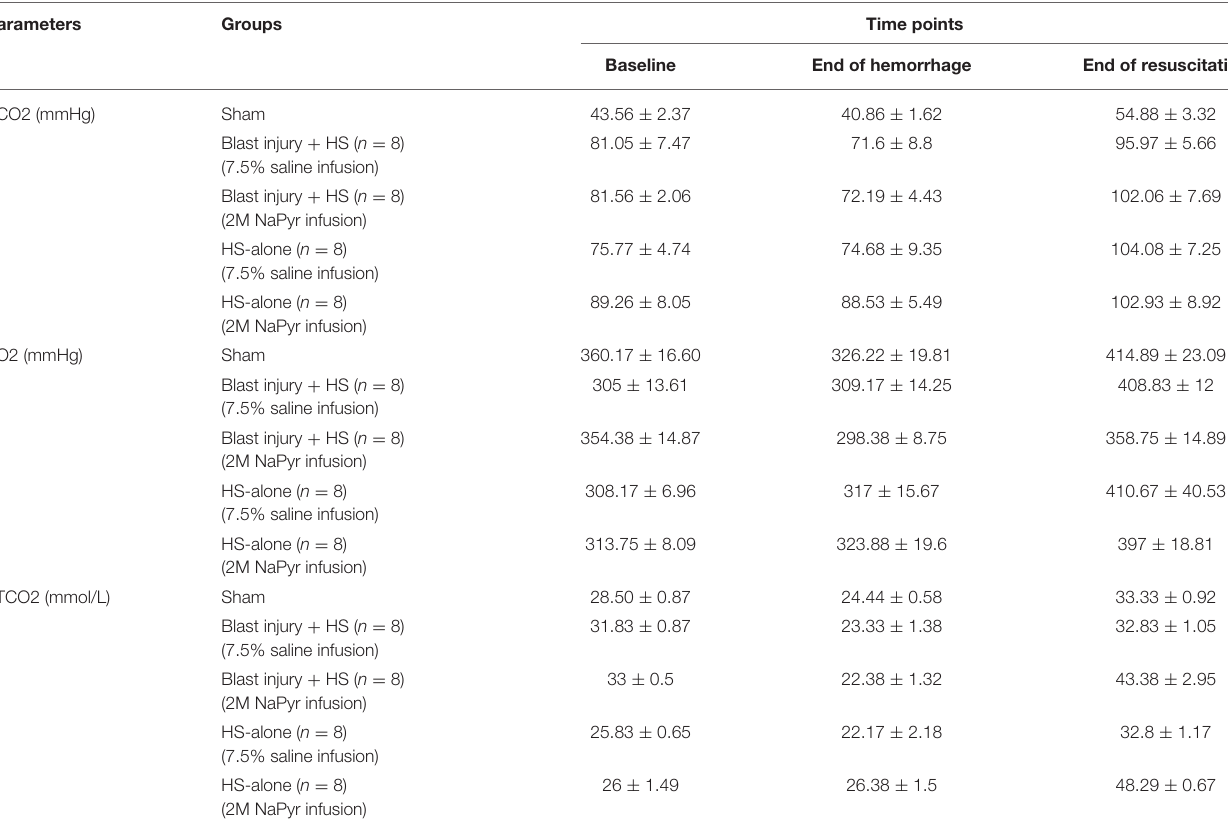
TABLE 2 | Blood gases in mean ± SE. Parameters